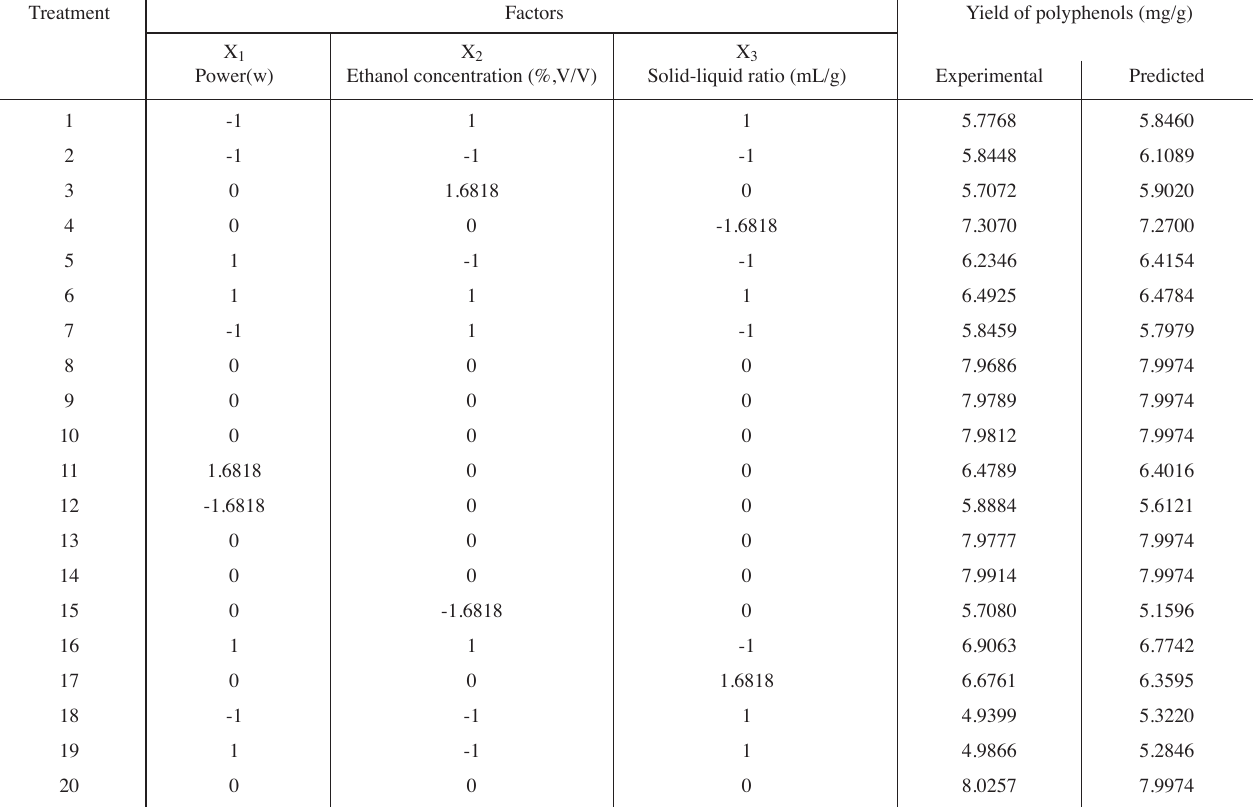
Tab. 2: Central composite design (CCD) plan in coded value and results of experiment